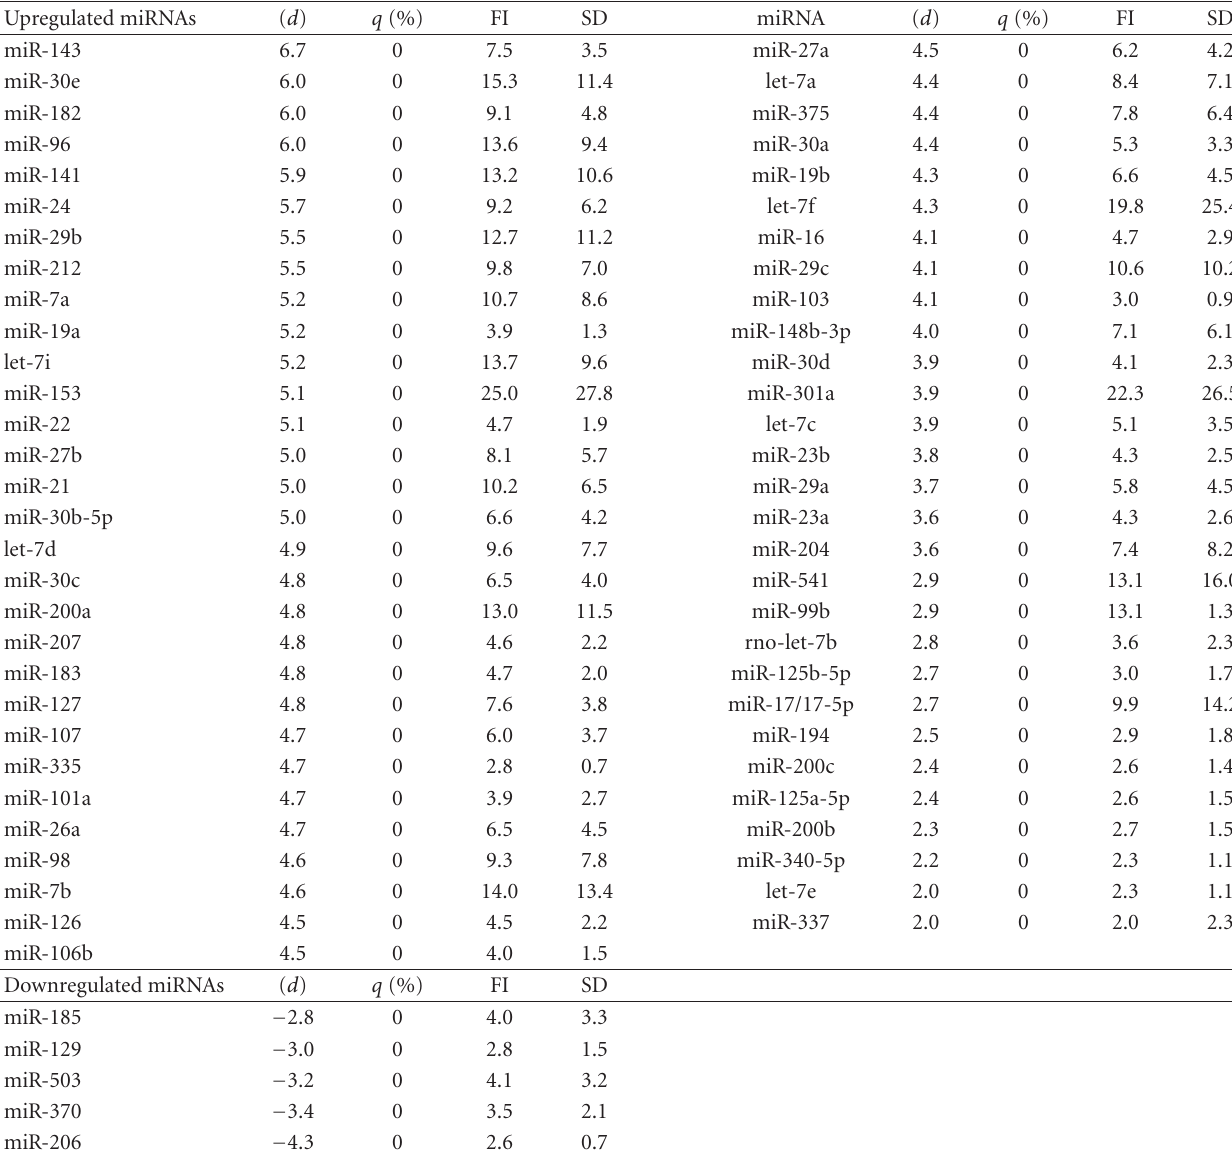
Table 1: miRNAs expressed in islets treated in vitro with a cocktail of IL-1 β , IFN- γ , and TNF- α were identified by SAM of global miRNAs. The score ( d ) represents value of the T-statistic; a higher score means a greater di ff erence between the two groups. q -values correspond to the P values adapted to the analysis of a large number of genes. FI and SD are fold increase and standard deviation of hybridization values (cytokine versus control),